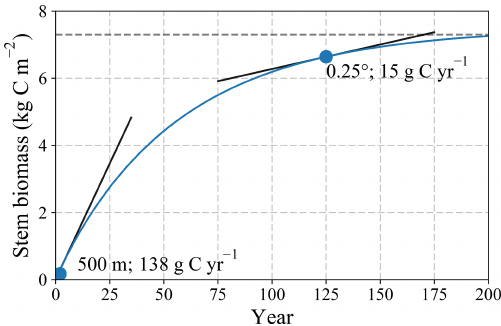
Figure 12. Typical stem biomass growth